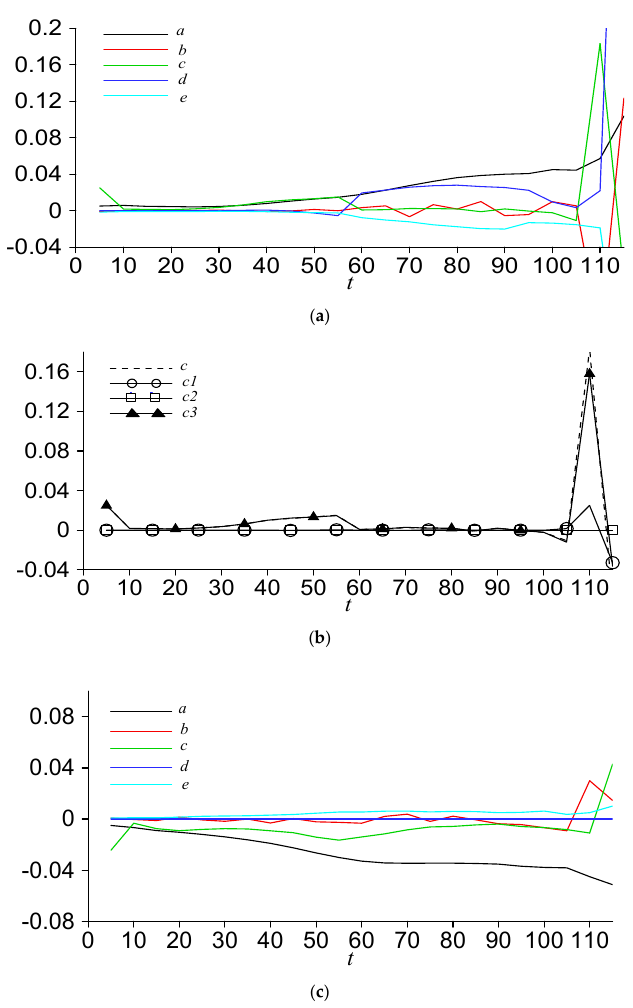
Figure 4. Evolution in time of the terms in the governing equations: ( a ) u (cid:48) > 0, P–N model; ( b ) u (cid:48) > 0, P–N model; ( c ) u (cid:48) < 0, P–N model; ( d ) u (cid:48) < 0, P–N model; ( e ) u (cid:48) > 0, N–P model; ( f ) u (cid:48) < 0, N–P